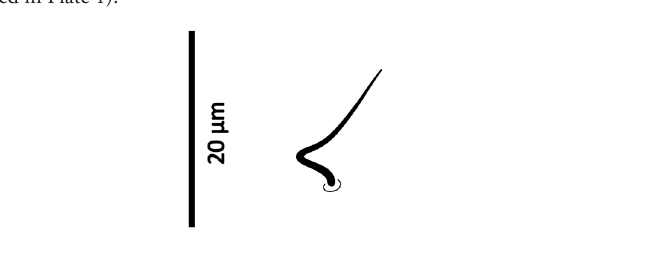
Figure 27. Seta av on palp trochanter of Zygoseius papaver sp. n., Z. lindquisti sp. n. and Z. furciger